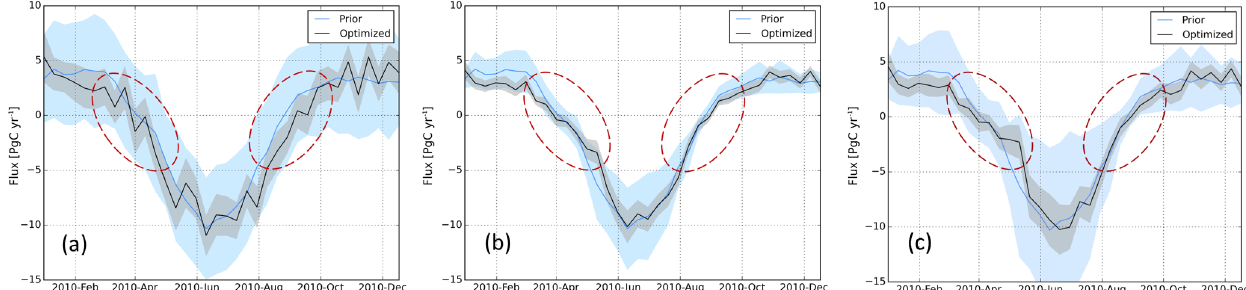
Figure 8. Comparison between two flux optimization methods: the additive method (a) gives significant different optimized fluxes, high- lighted by the red dashed ellipses, in contrast to the multiplicative method (b) , and (c) is similar to (b) but with 2 times the flux uncertainty, i.e., setting the biosphere scaling parameter variance to 160%. The additive method seems more flexible to adjust fluxes in case net carbon exchange is small or even close to zero around the shoulder seasons (spring/fall).